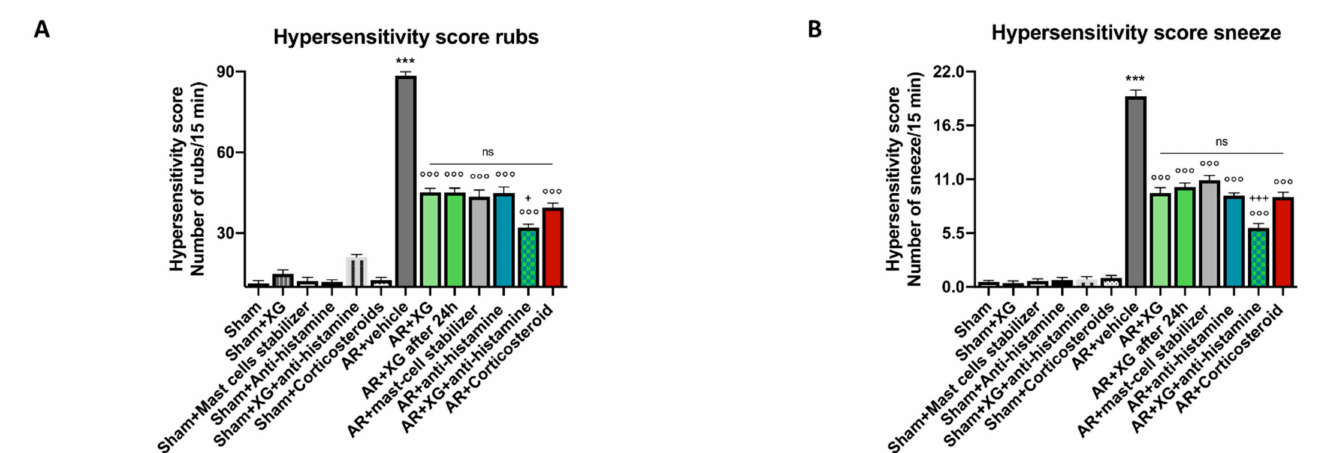
Figure 1. Effects of XG based spray on AR symptoms. A considerable increase in number of rubs and in number of sneezes was detected in AR mice compared to sham groups ( A , B ). The administration of XG based spray alone is effective to decrease the number of rubs and sneezing in a manner that is comparable to treatment with the mast-cell stabilizer and antihistamine ( A , B ). Moreover, XG based spray in association with antihistamine was able to effectively decrease AR symptoms similarly to corticosteroid-administered animals ( A , B ). Data are representative of at least three independent experiments. Values are means ± SEM. One-Way ANOVA test. *** p < 0.001 vs. Sham; ◦◦◦ p < 0.001 vs. AR + vehicle;